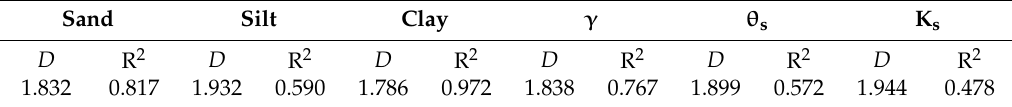
Table 4. Fractal dimension values of soil properties (isotropy).